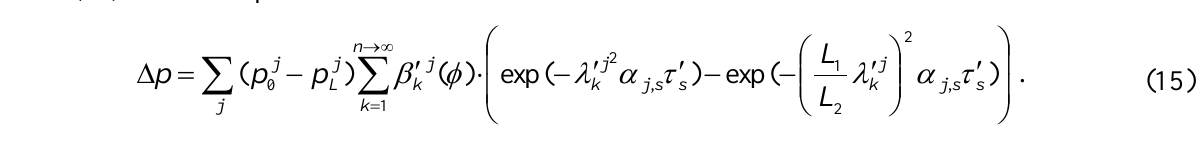
necessary for the at  and near )( at 1 1 L